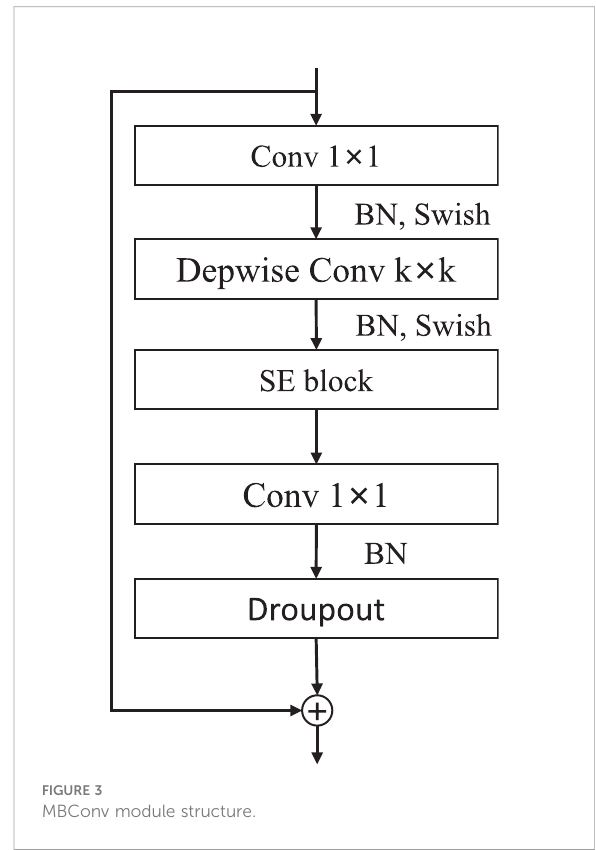
FIGURE 3 MBConv module structure.